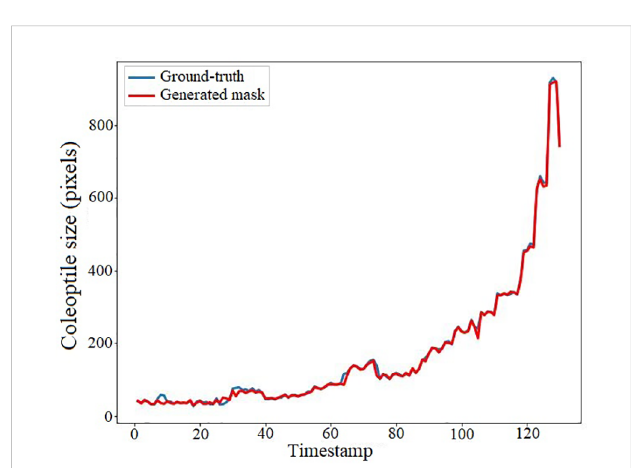
FIGURE 12 Coleoptile size measured by the total number of constituent pixels of the ground-truth (shown in blue) and the generated mask (shown in red) as a function of